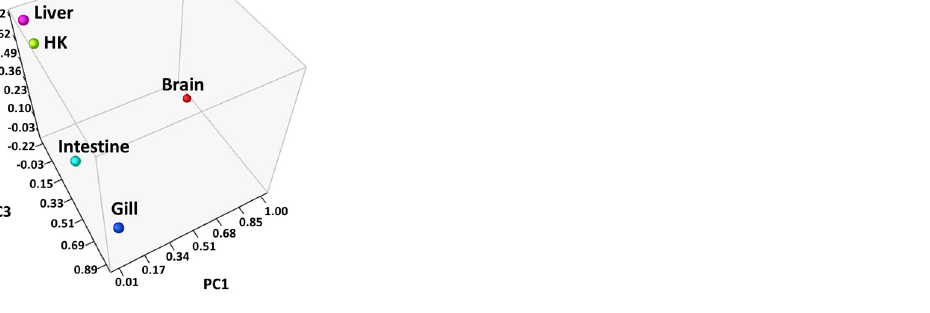
Figure 2. Principal component analysis (PCA) of the genes in all samples: Fold changes in each organ were converted to principal component values and visualized in three-dimensional coordinates, and the head kidney (HK) and liver were located closer to each other than the other organs. Table 2. A total of 22 differentially expressed genes common in five organs of common carp under hypoxic conditions.